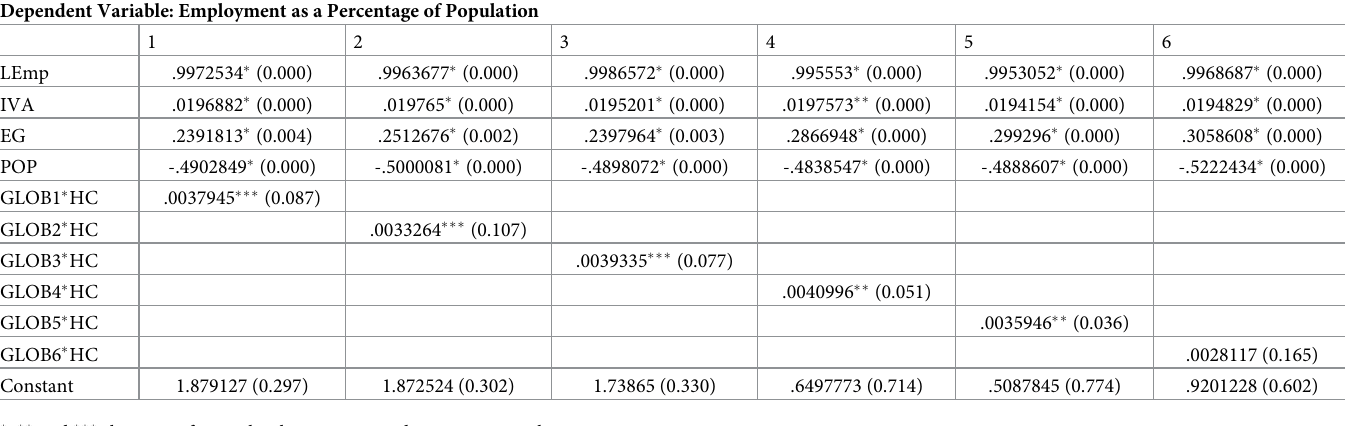
Table 11. Indirect impact of globalization on employment through human capital (system GMM